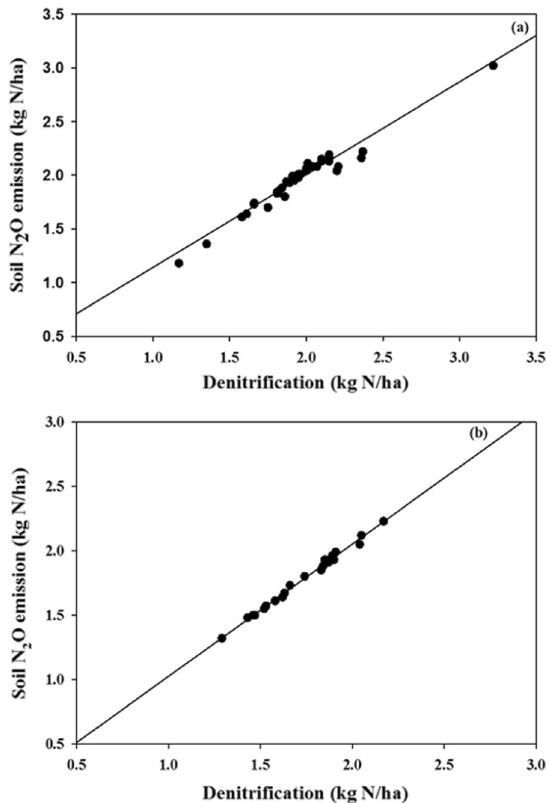
Fig. 6 The relationship between soil N 2 O emission and denitrification rate based on the long-term dataset ( a ) and under different precipitation treatments ( b